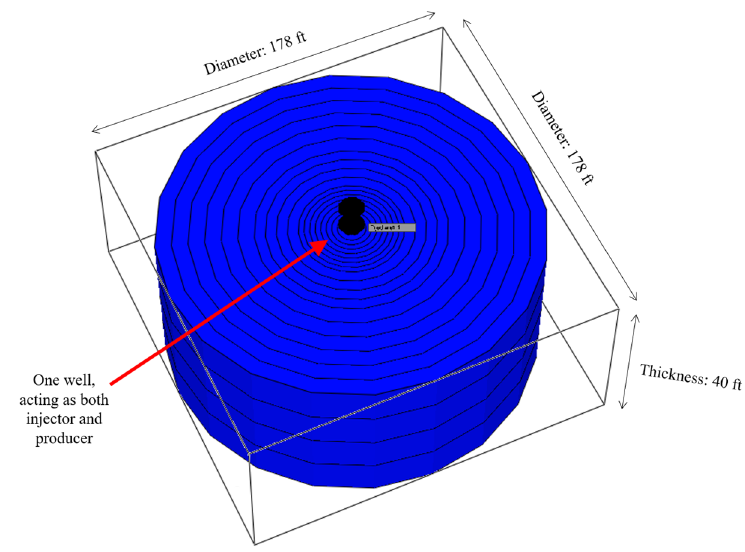
Figure 2. Synthetic 1-well, 3D cylindrical reservoir model.